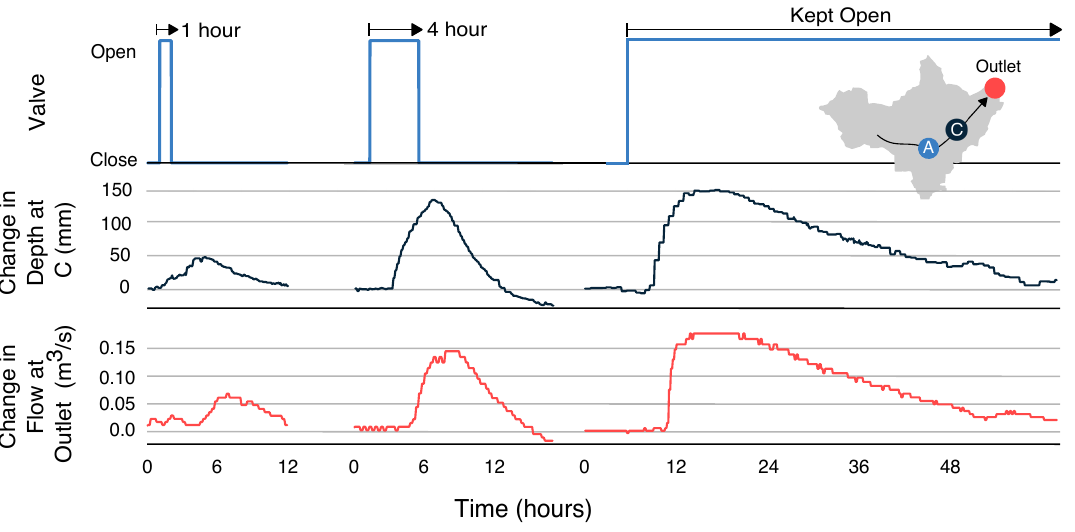
Figure 3. Characterization of control actions from site A. In the first two experiments, the valve at site A is opened for 1-h and 4-h durations. For the third experiment, the valve is held open indefinitely. The resulting waves travel through a constructed wetland (site C) before arriving at the outlet of the watershed. Wave depth (black line) is measured at the wetland, while flow rate (red line) is measured at the outlet.